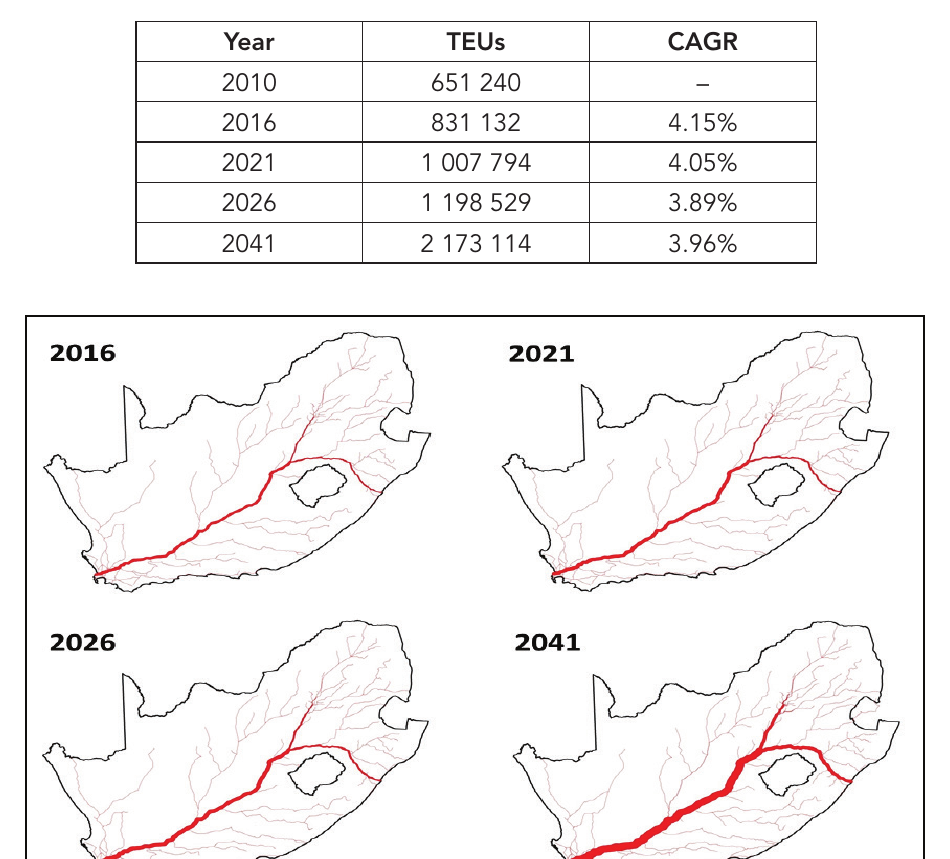
Table 2: Total loaded container volumes and CAGR for the catchment area